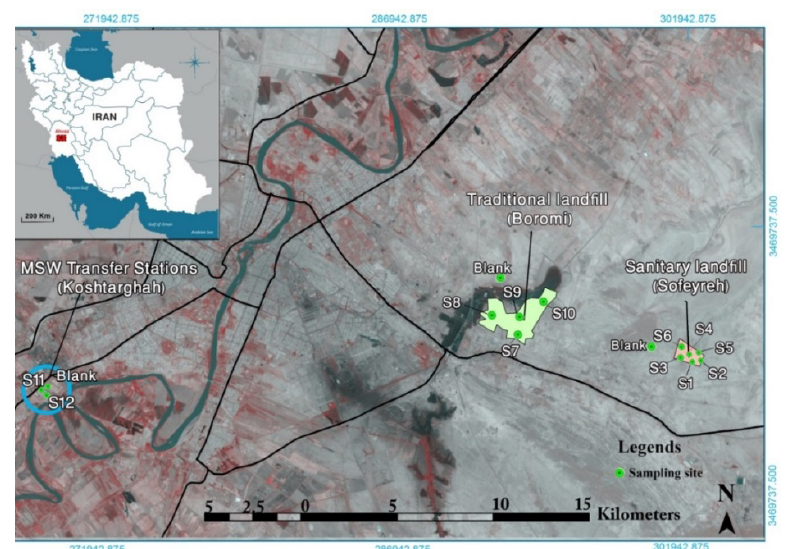
Figure 1. Location of the study area and distribution of sampling sites in Ahvaz metropolis